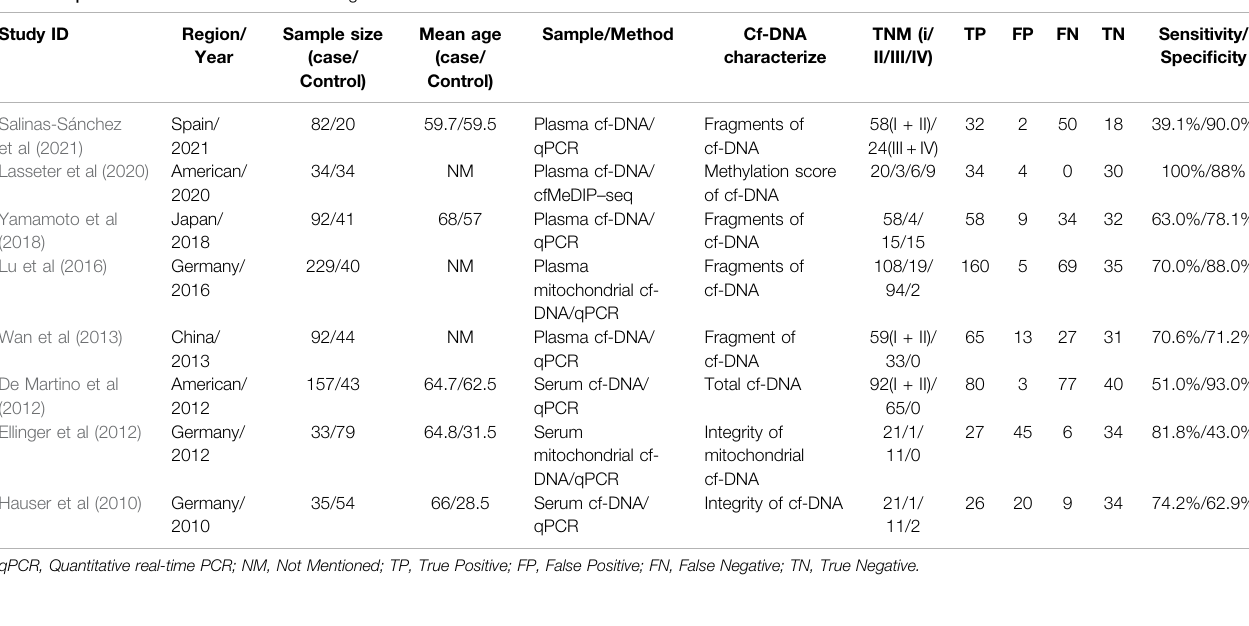
Frontiers in Molecular Biosciences |